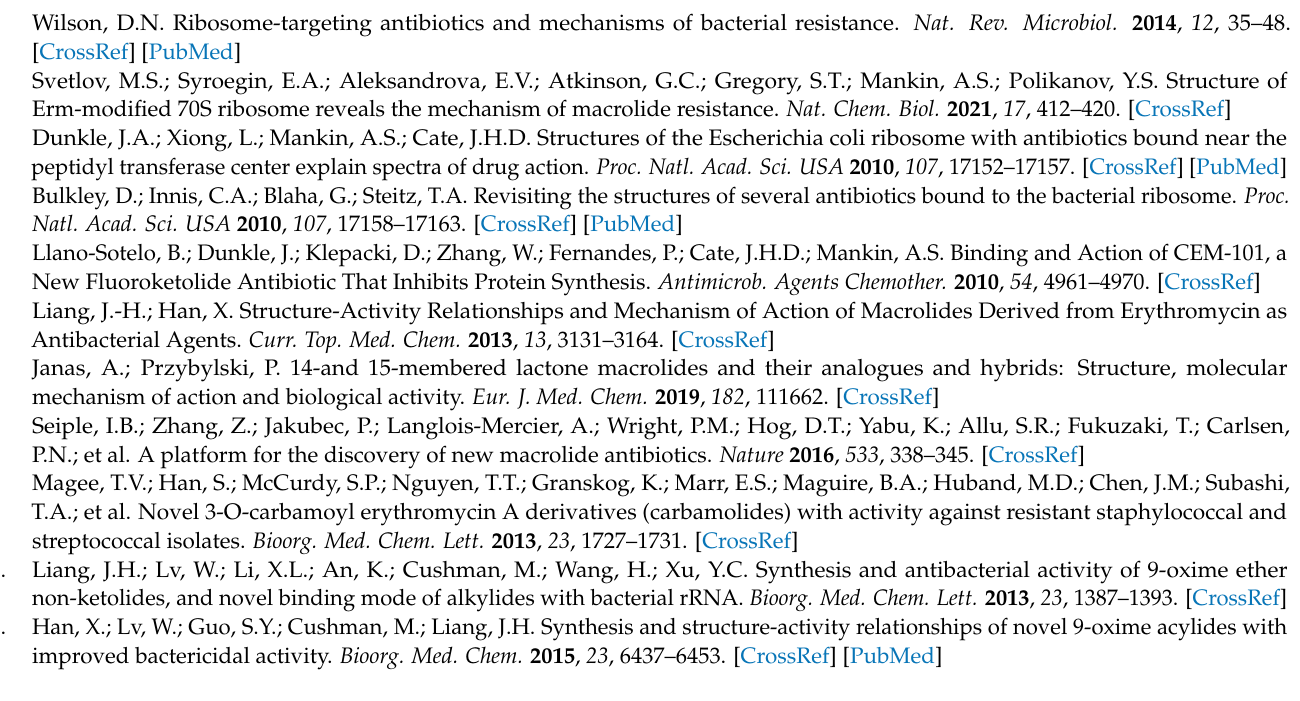
dynamic simulation. Table S4: The interaction of hydrogen bonds between G2099A mutant 50S ribosomal subunit (PDB ID: 1YHQ) and 32A after molecular dynamic simulation. Table S5: HRMS and NMR spectra checklist for the intermediates and target compounds ( 1 – 16 and 26 – 37 ). 1 H and 13 C NMR Spectra for the representative